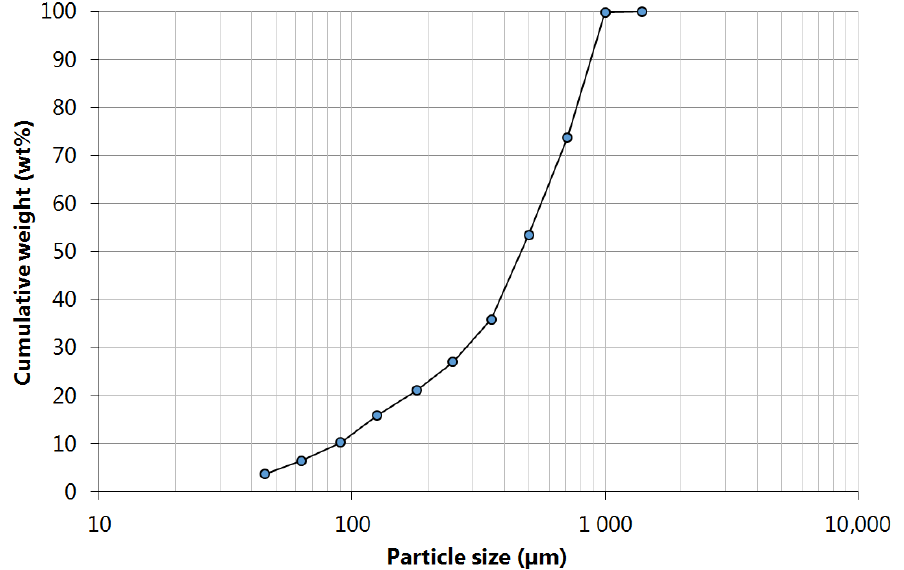
Figure 1. Particle size distribution of the SACC powder sample.